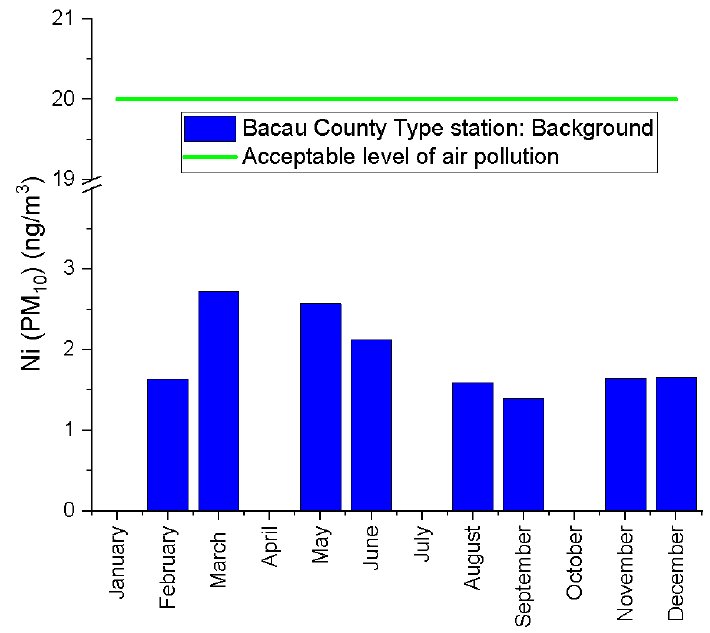
Figure 18. Average Ni concentration in the year 2020. The highest average recorded value for the Pb (Figure 19) quality parameter was in August, 0.091 µg m − 3 , while the lowest value for this parameter was in December, 0.0053 µg m − 3 . According to the current legislation, the permissible limit value is 0.5 µg m − 3.